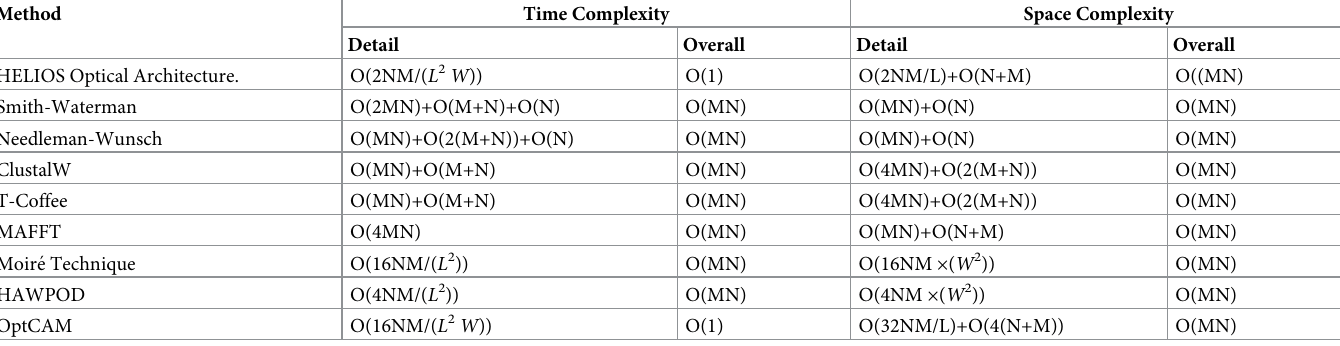
Table 16. Time and space complexities of the HELIOS compared to well-known algorithms, performing a pairwise sequence alignment. In this table, N and M are the lengths of the first and the second input sequences, respectively, assuming N > M. Moreover, the parameter L × W is the size of the aperture of modulators, used in HELIOS optical architecture. As represented in this table, HELIOS offers a fraction of MN by L2 × W for time complexity, leading to O(1) in the case of large modulators. Detail Overall HELIOS Optical